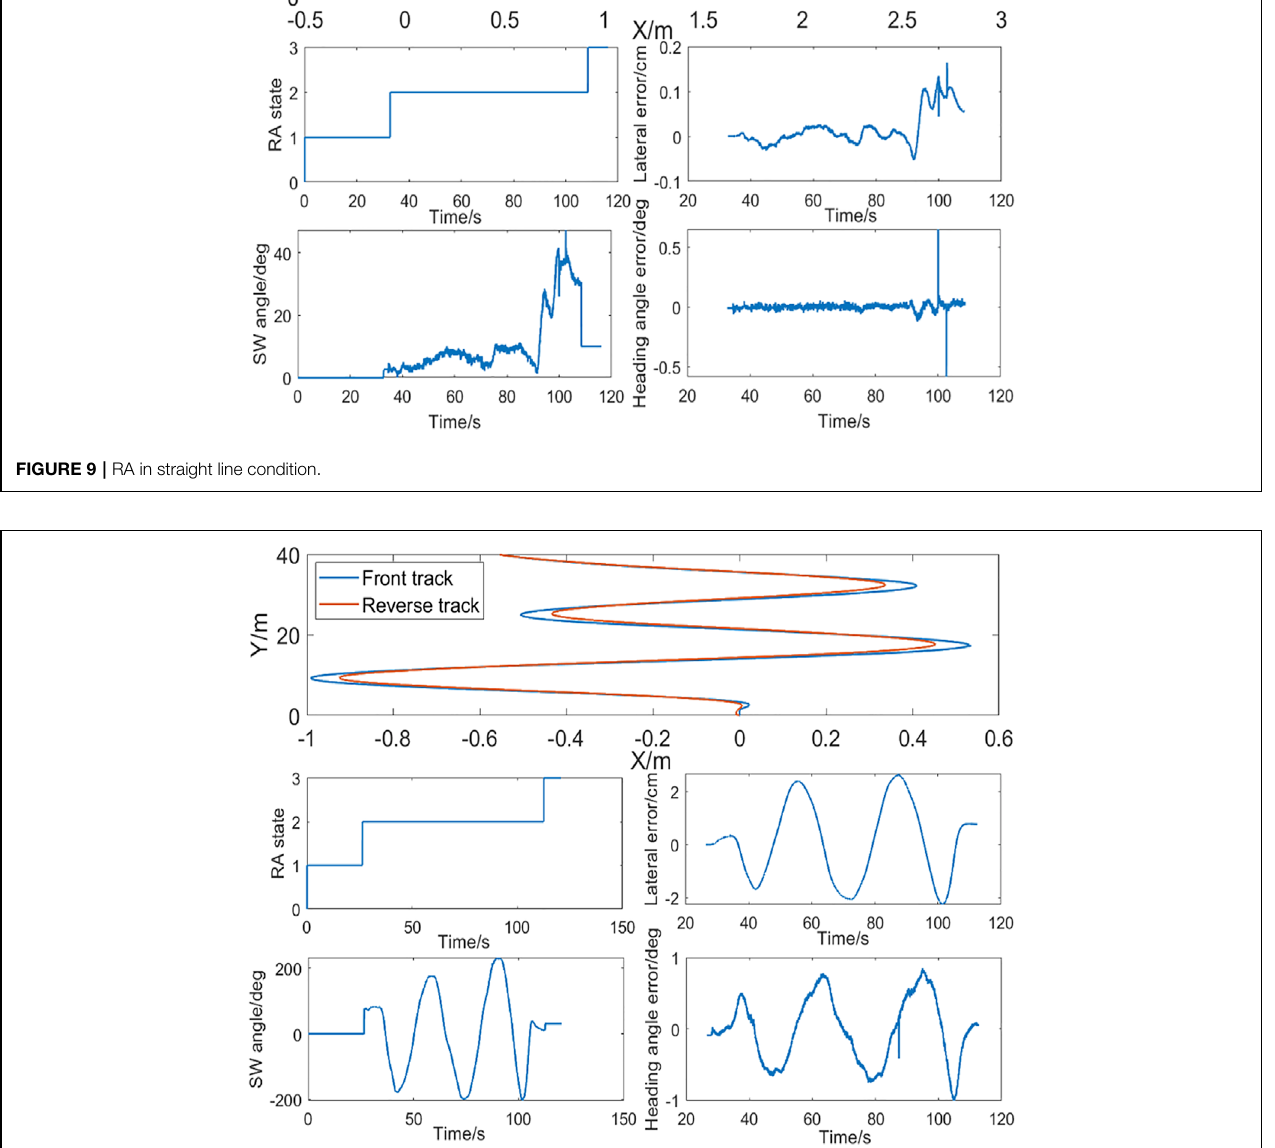
FIGURE 10 | RA in S-shaped